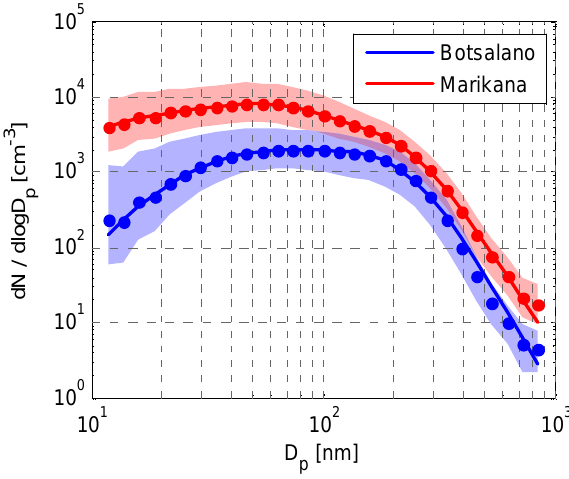
Fig. 3. Median distributions for Botsalano and Marikana. The dots indicate the median measured distribution and the lines show the fitted log-normal distribution from Table 2. Shaded areas indicate the upper and lower